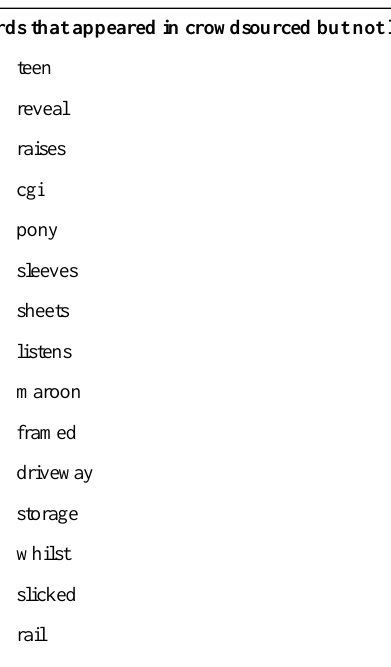
Table 2. Comparison of crowdsourced and lab-sourced vocabulary.